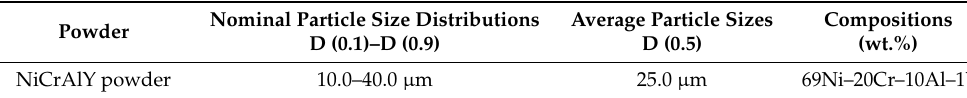
Table 1. Size distributions and compositions of NiCrAlY powders.